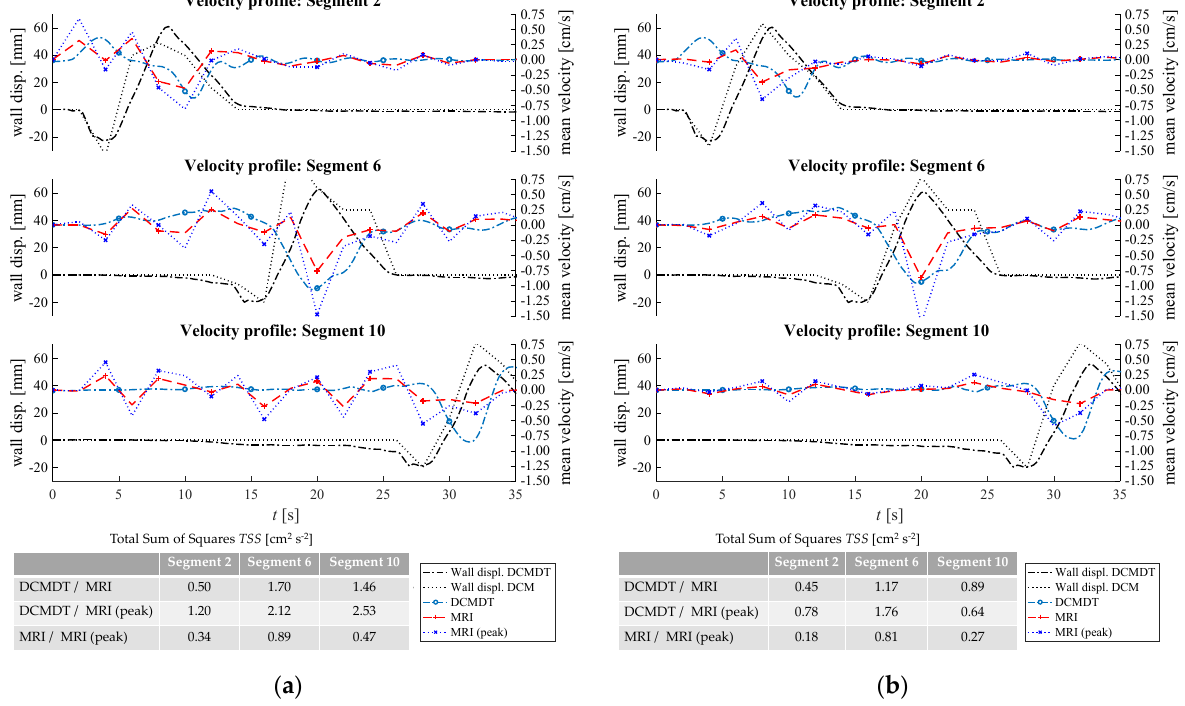
Figure 11. Comparison of the fluid velocities and wall displacement profiles of the DCM and the DCMDT at high fluid volume and fast propagating PPW. In ( a ) the mean fluid velocities at low fluid viscosity and in ( b ) the mean fluid velocities at high fluid viscosity are compared. Generally, mean velocities were slightly higher in the DCM than in the DCMDT. Comparison of Figure 12 parts (a) and (b) demonstrates the influence of propagating a faster wave produces higher velocities in both the DCM and the DCMDT.